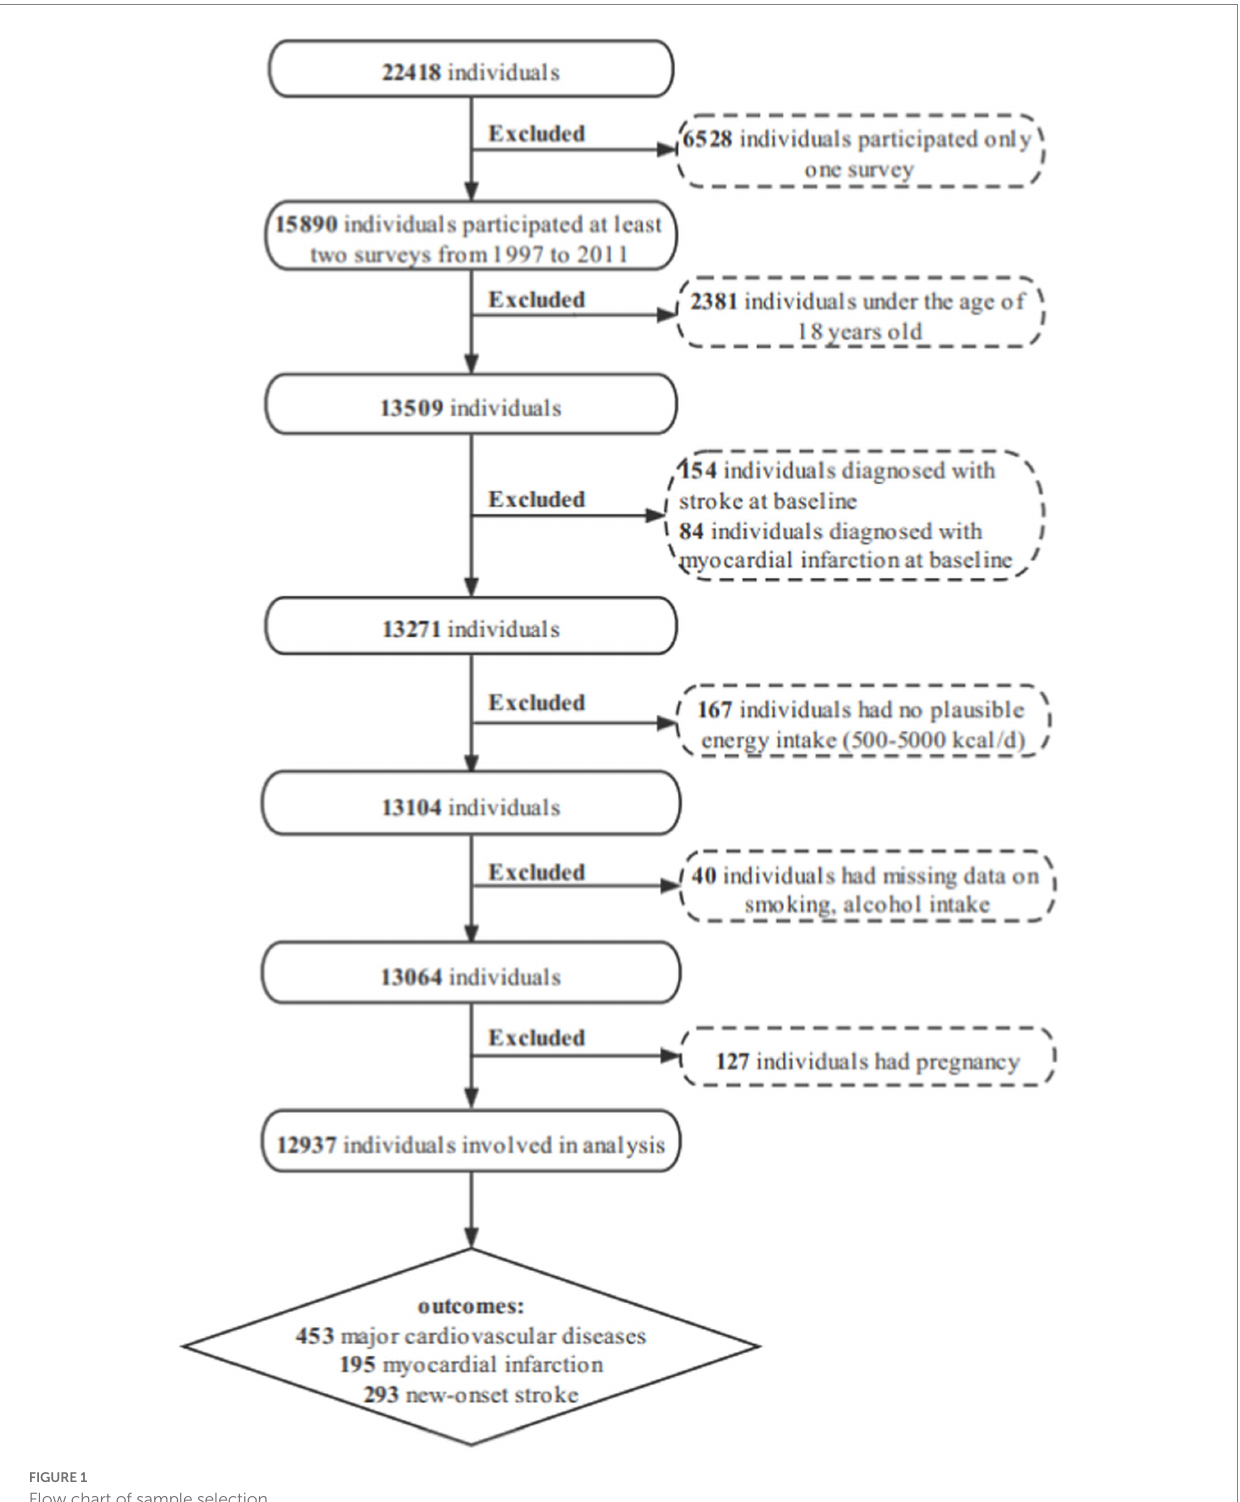
FIGURE 1 Flow chart of sample